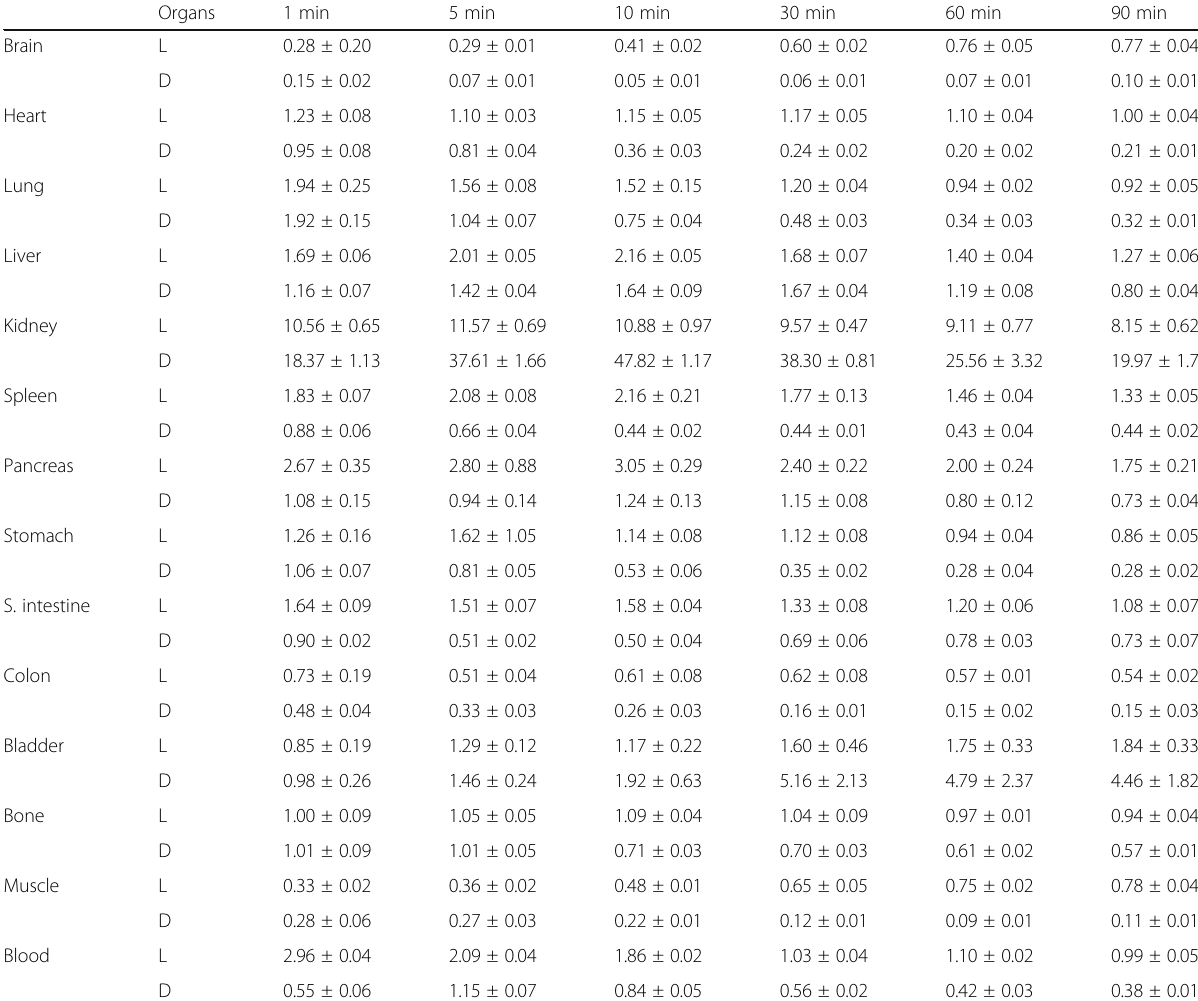
Table 1 Distribution and kinetics of L- and D- 18 F-FBPA in normal rats